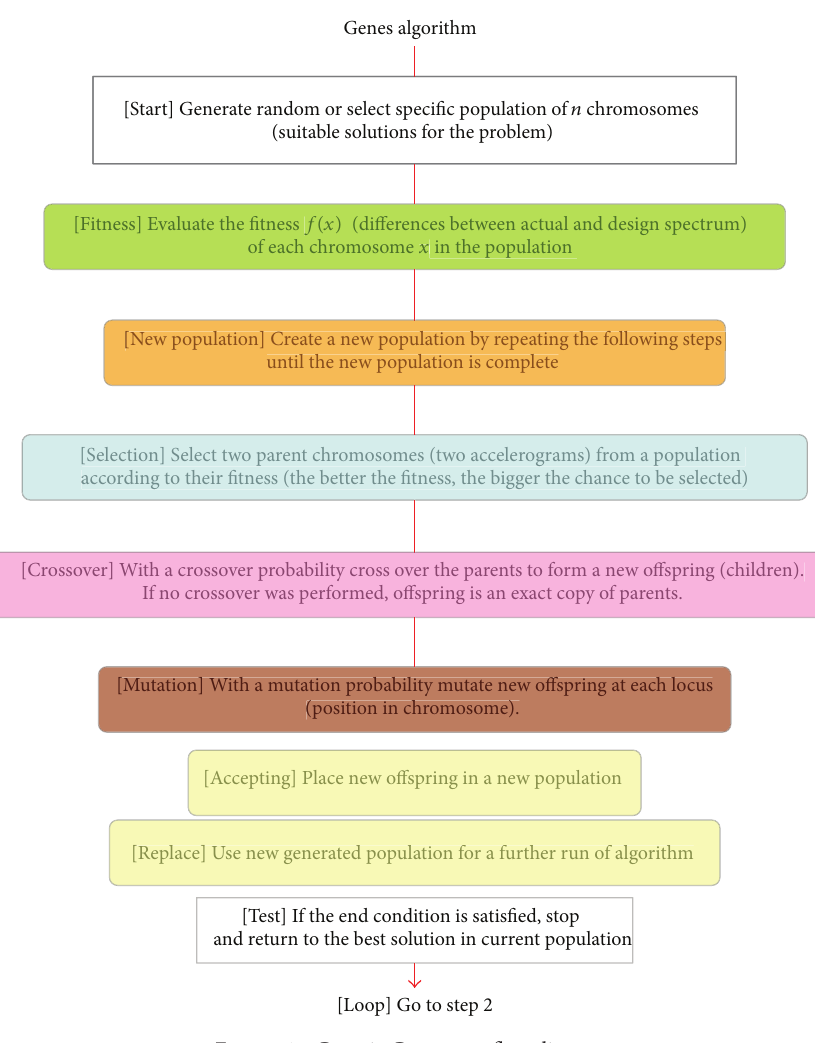
Figure 15: Genetic Generator: flow